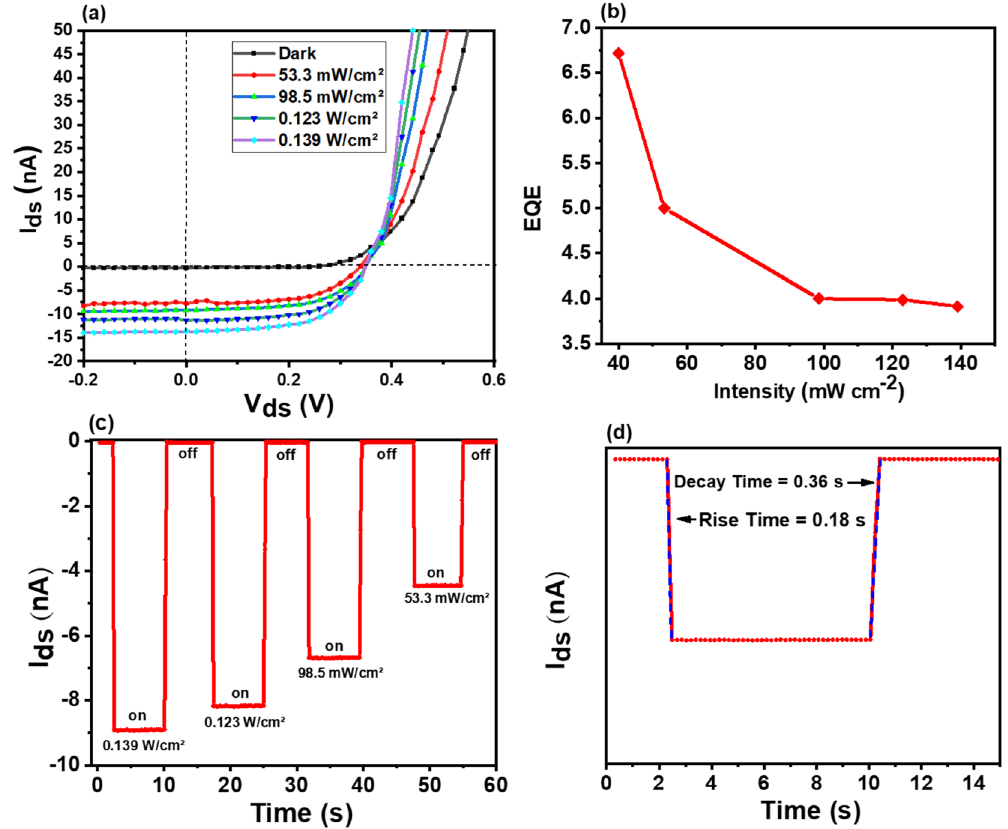
Figure 5. (a) The I–V characteristics of p-GeSe/n-MoSe 2 heterojunction diode under dark and variable intensities. (b) The external quantum efficiency EQE function of incident power. (c) The time-dependent photoresponse of p-GeSe/n-MoSe 2 heterojunction diode under illuminations with different laser light (@850 nm) intensity at V ds = 0 V. (d) The rise time and decay time.